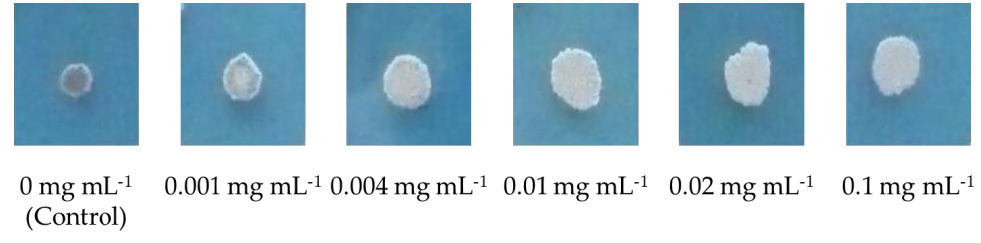
Figure 3. Illustration of Zymoseptoria tritici fungal growth on PDA medium amended with surfactin at six concentrations: 0.1 mg mL −1 , 0.02 mg mL −1 , 0.01 mg mL −1 , 0.004 mg mL −1 , 0.001 mg mL −1 , and 0 mg mL −1 (Control).